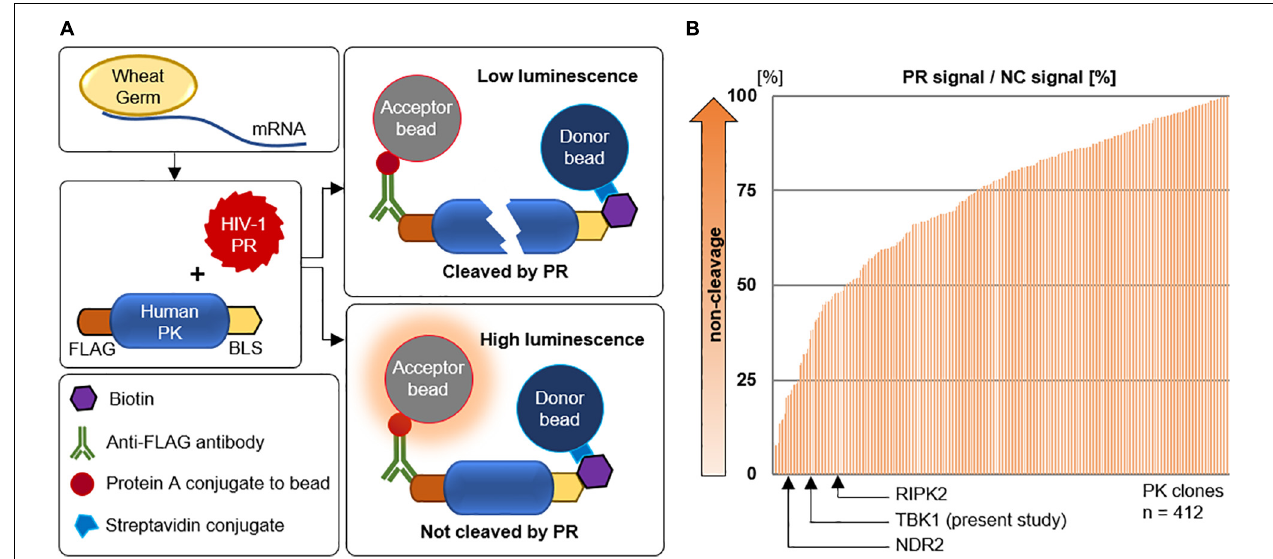
FIGURE 1 | Screening for human kinases cleaved by HIV-1 protease. (A) Schematic representation of the AlphaScreen assay performed with HIV-1 protease and various human protein kinases generated by wheat germ cell-free protein synthesis. PR protease, PK protein kinase, GST glutathione S-transferase, BLS biotin linker sequence. (B) AlphaScreen assay result of the 412 human protein kinases arranged in order of cleavage to non-cleavage. TANK binding kinase-1 was identified in this study along with two other previously reported protein kinases. PR protease, NC negative control represents dihydrofolate reductase (DHFR), a protein that is not cleavable by HIV-1